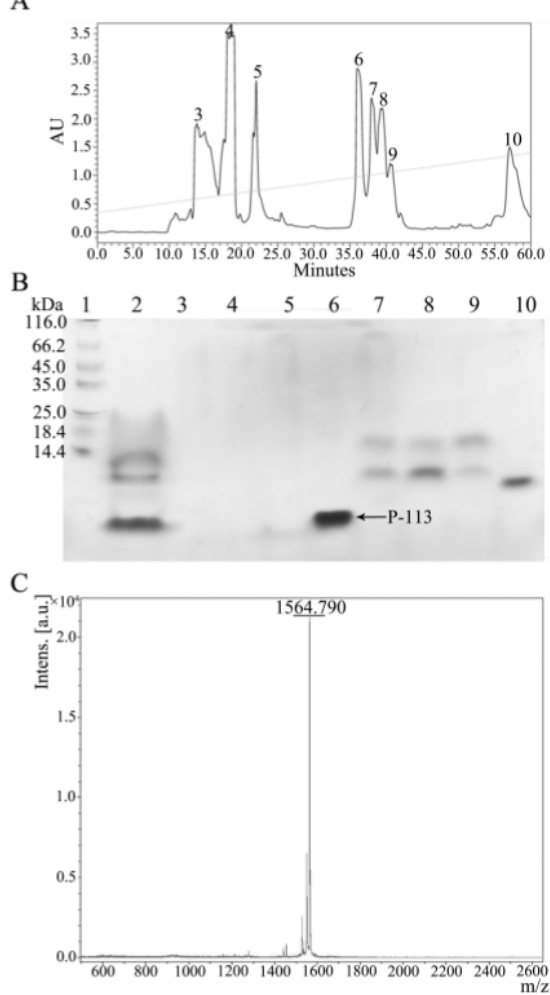
Figure 5. ( A ) Reversed-phase HPLC purification of hG31P-P-113 after cleavage by CNBr. ( B ) SDS-PAGE analysis of the HPLC fractions. P-113 peptide eluted out at 36 min. Lane 1 : protein marker; Lane 2 : mixture after CNBr cleavage; Lanes 3 – 10 : peak collection of retention time from HPLC. Proteins were stained with Coomassie brilliant blue. ( C ) Mass analysis of fraction 6 from HPLC. The MW of the purified P-113 was found to be 1564.790 Da based on MALDI-TOF MS. The theoretical MW of P-113 was calculated to be 1564.870